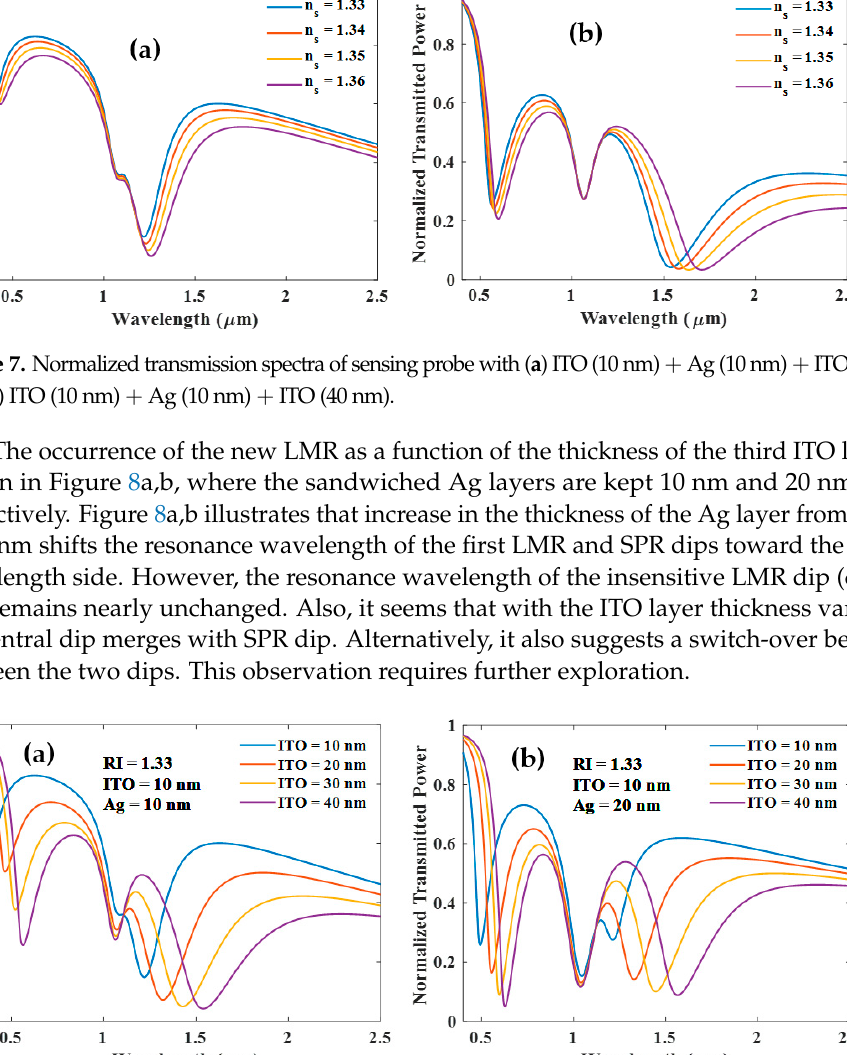
ITO (X nm) and ( b ) ITO (10 nm) + Ag (20 nm) + ITO (X nm). and ( b ) ITO (10 nm) + Ag (20 nm) + ITO (X